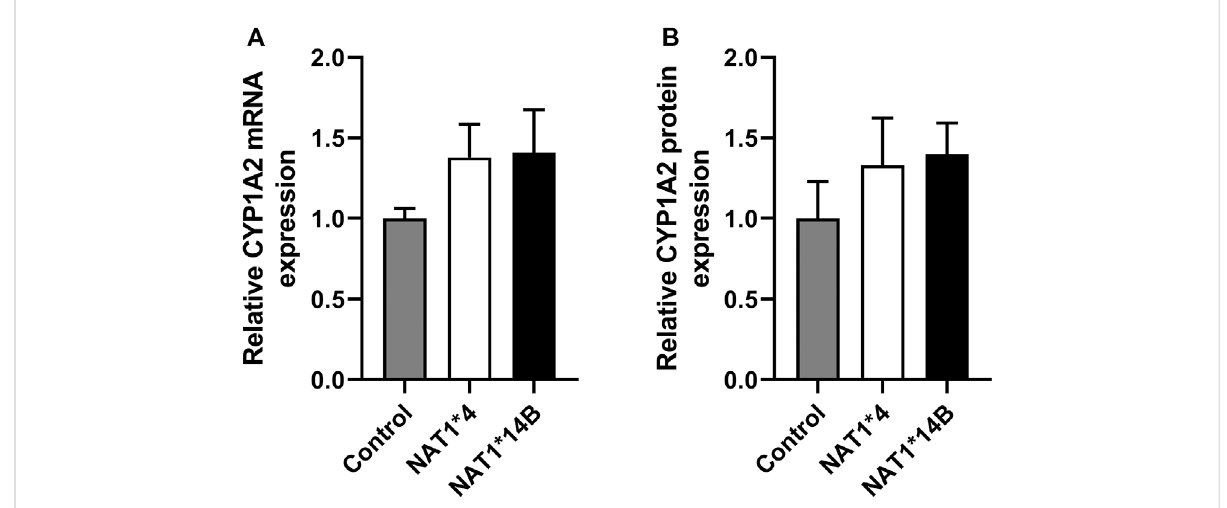
FIGURE 1 CYP1A2 (A) mRNA and (B) protein expression. CYP1A2 mRNA and protein levels were higher in CYP1A2-transfected compared to non- transfected (control) CHO cells and did not differ signi fi cantly among the CHO cells transfected with CYP1A2 and NAT1*4 or NAT1*14B . ( p > 0.05). Statistical signi fi cance was determined using one-way ANOVA followed by a Tukey ’ s ’ s post-hoc test. Data illustrates mean ± SEM of four replicates.